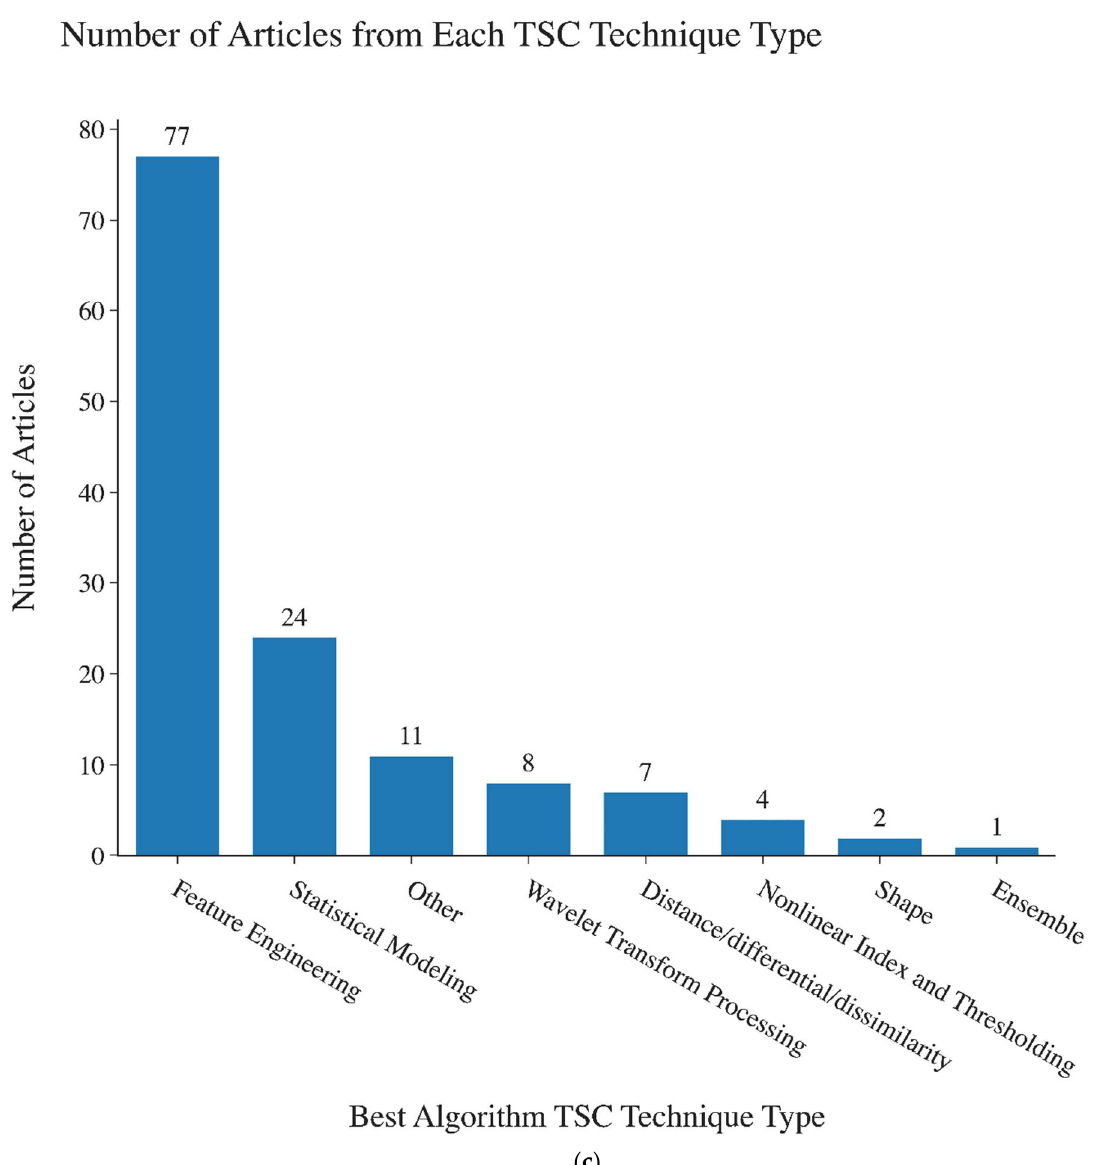
Figure 2. ( a ). Numbers of papers found in this review focusing on each different biosignal type specified on the horizontal axis. ( b ). Conceptual representation of non-deep learning time series classification modeling types. [1,16–20]. ( c ). Number of articles found for the categories of time series classification methods (horizontal axis) used in biomedical applications.